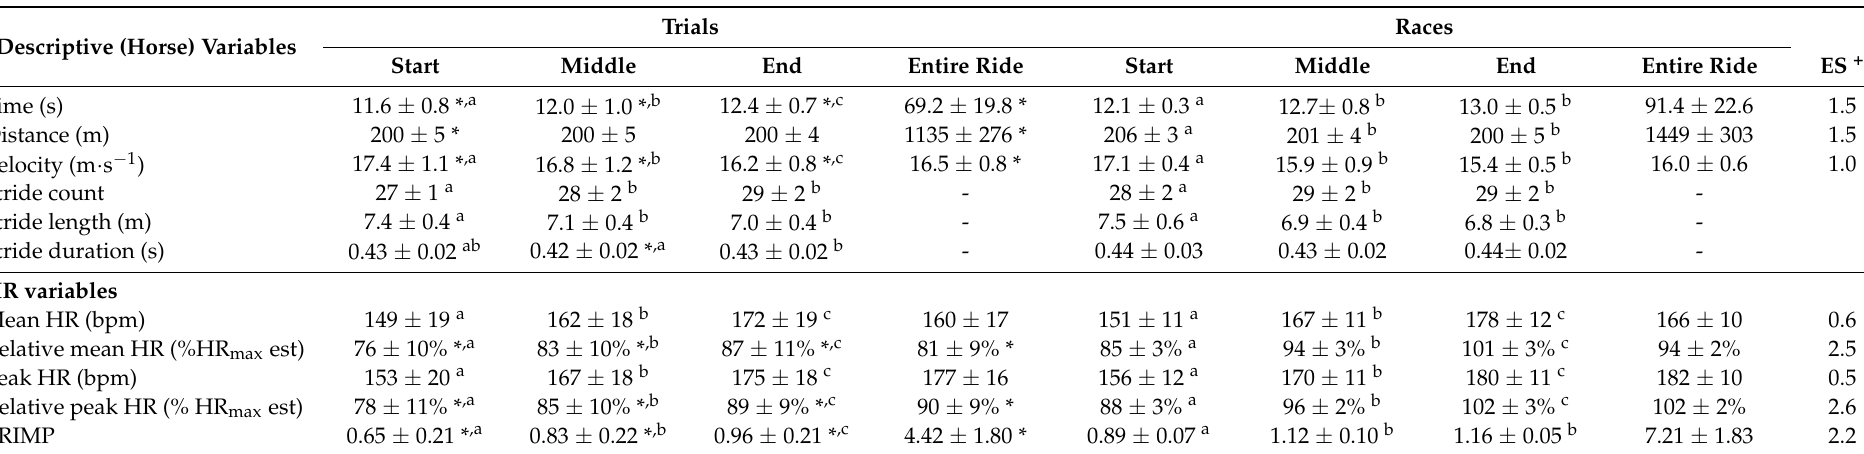
Table 3. Descriptive data (mean ± SD) of the characteristics of the trial ( n = 52) and race ( n = 16) rides and corresponding jockey physiological response per